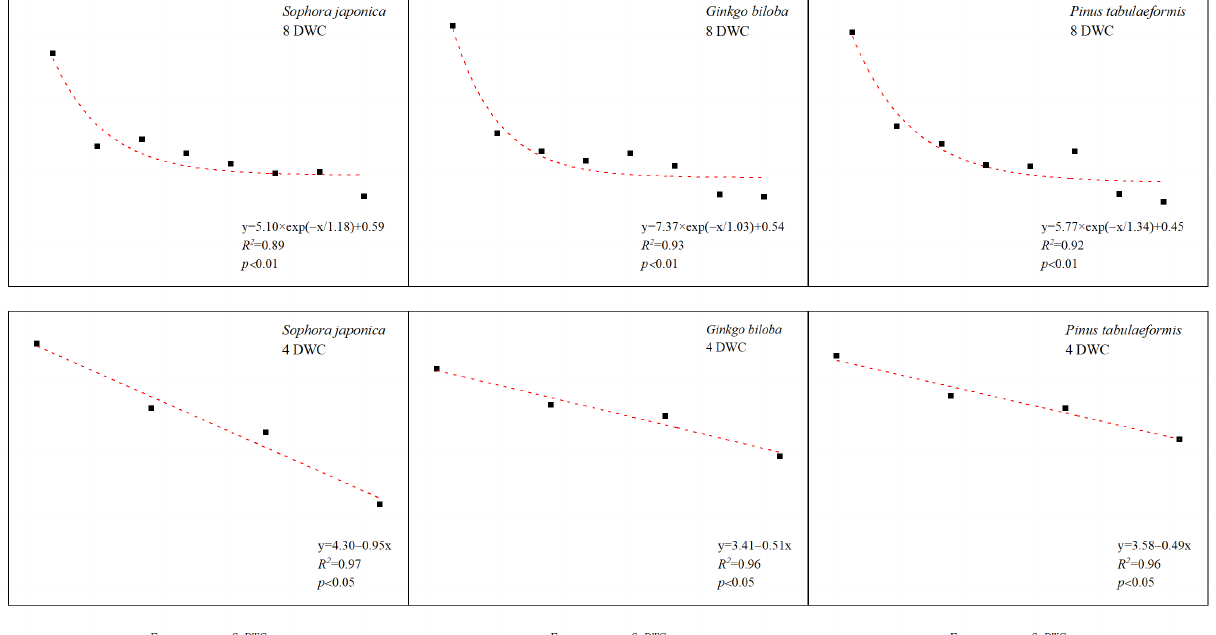
Table 3. Alpha diversity indices of soil bacterial communities under different treatments.